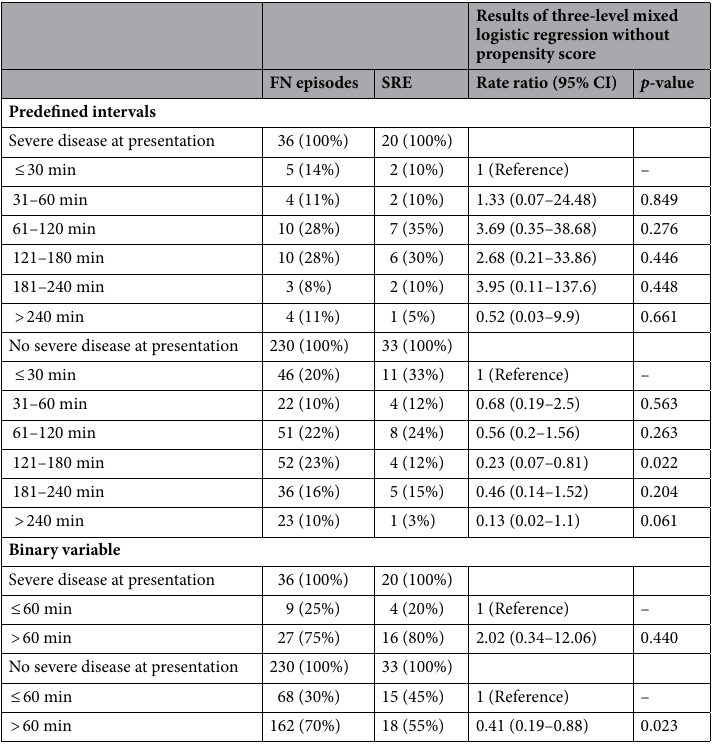
Table 2. Stratified analysis according to severity of disease at presentation for the association of time from fever to start of antibiotics (TTA) and the occurrence of safety relevant events (SRE). CI confidence